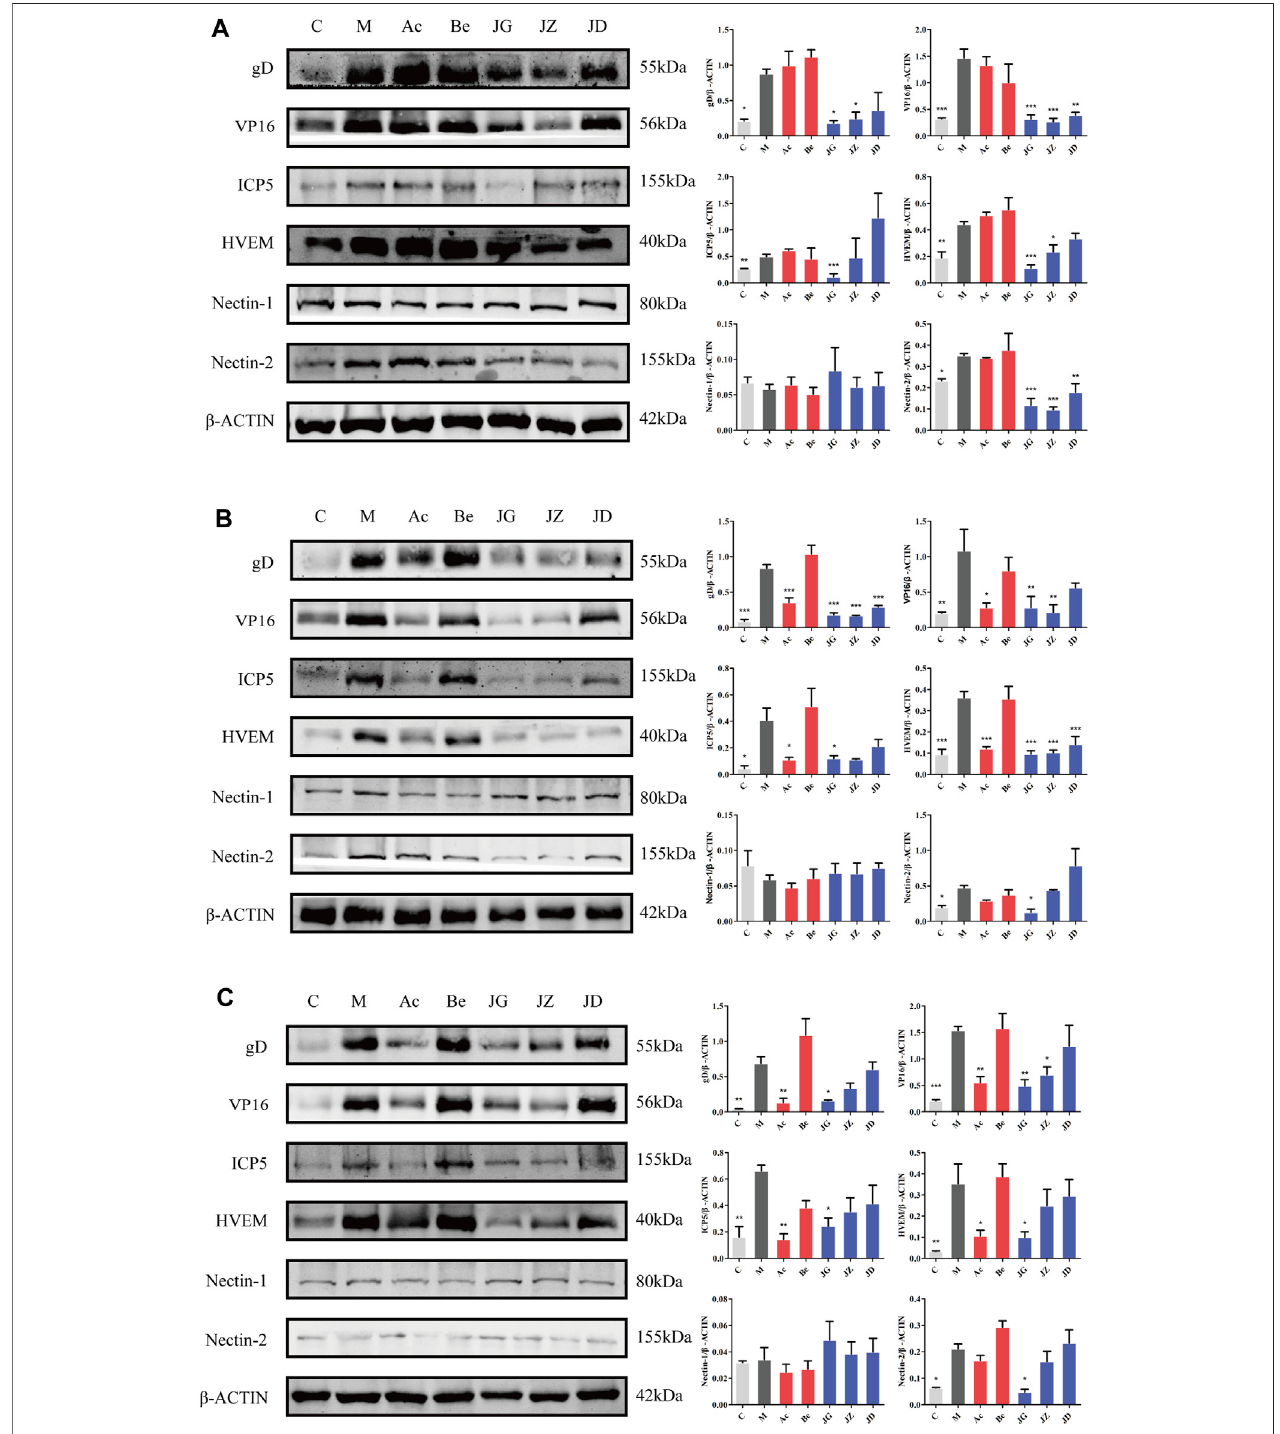
FIGURE 8 | Effect of JZ-1 on the expression of membrane fusion-related proteins in vaginal (A, B) and vulvar (C) tissues of GH mice. On 12 h (A) and day 9 (B, C) after modeling, the key proteins of membrane fusion, including gD, VP16, ICP5, HVEM, and Nectin-2, were measured by western blot. JZ-1 inhibited virus adsorption andpenetrationbydownregulatingtheexpressionofmembranefusion-relatedproteins.C,controlgroup;M,modelgroup;Ac,acyclovirgroup;Be,berberinegroup;JG, JZ, JD: 2.5, 1.5, and 0.5 g/ml JZ-1 group. *p ＜ 0.05, **p ＜ 0.01, ***p ＜ 0.001 vs. M group.